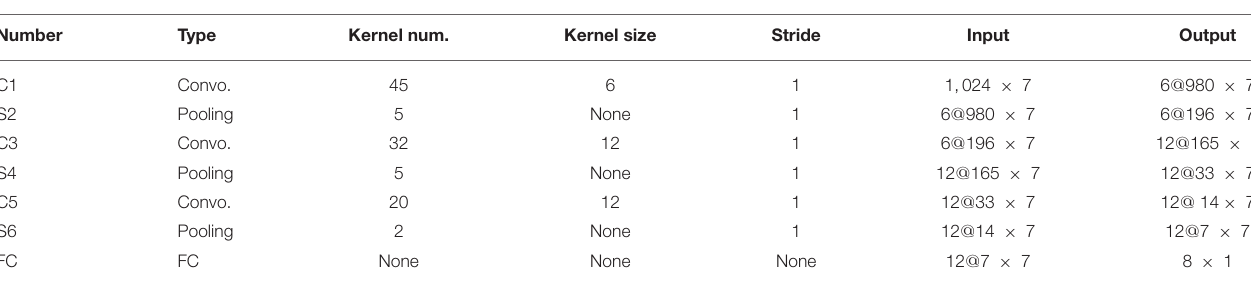
TABLE 3 | Detailed parameters of each layer in the CNN.